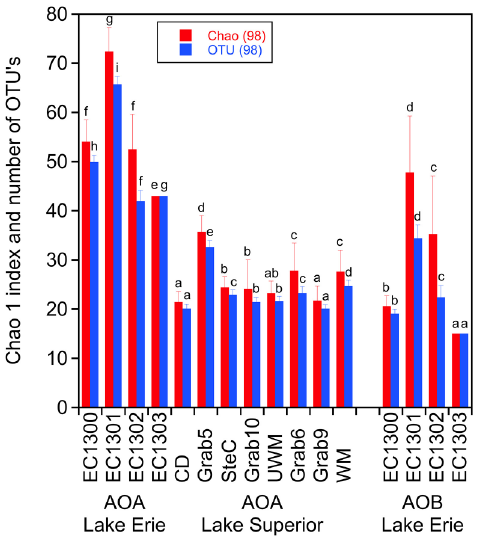
Figure 3. Alpha-diversity at 98% identity and singletons removed of the AOA and AOB amoA sequence libraries. (mean 6 SD, n=100 rarefactions; different letters in figure A above the columns indicate significant differences between samples determined by one-way ANOVA followed by Tukey test; p , 0.05; data for AOA and AOB were tested